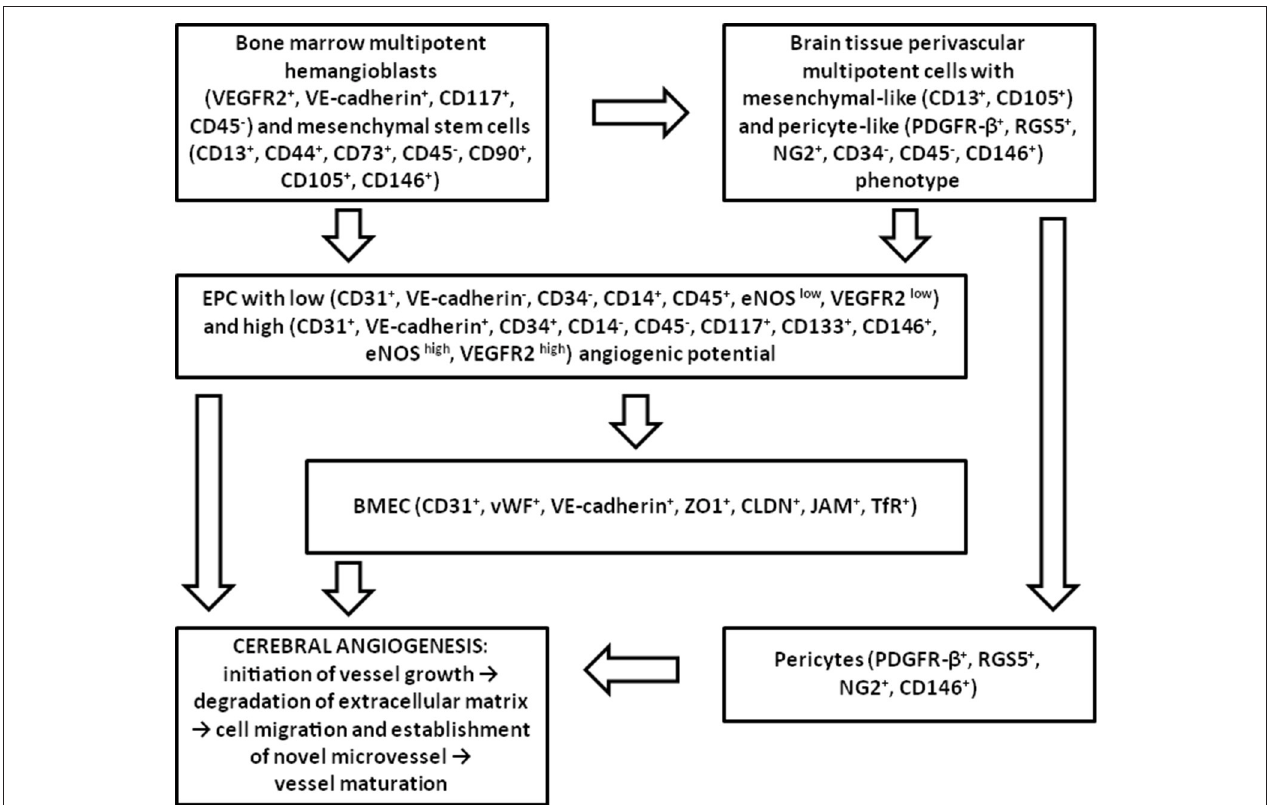
FIGURE 2 | Participation of different types of EPC in adult brain angiogenesis. In the adult brain, EPC originated from the bone marrow multipotent hemangioblasts and MSC, or from the multipotent mesenchymal-like and pericyte-like cells located in cerebral microvessels, give rise to the population of EPC which is able to activate BMEC, to integrate into the endothelial layer, and to promote recruitment and proliferation of pericytes upon the action of pro-angiogenic stimuli. Later, perivascular cells coordinate acquisition of endothelial quiescence and vessel